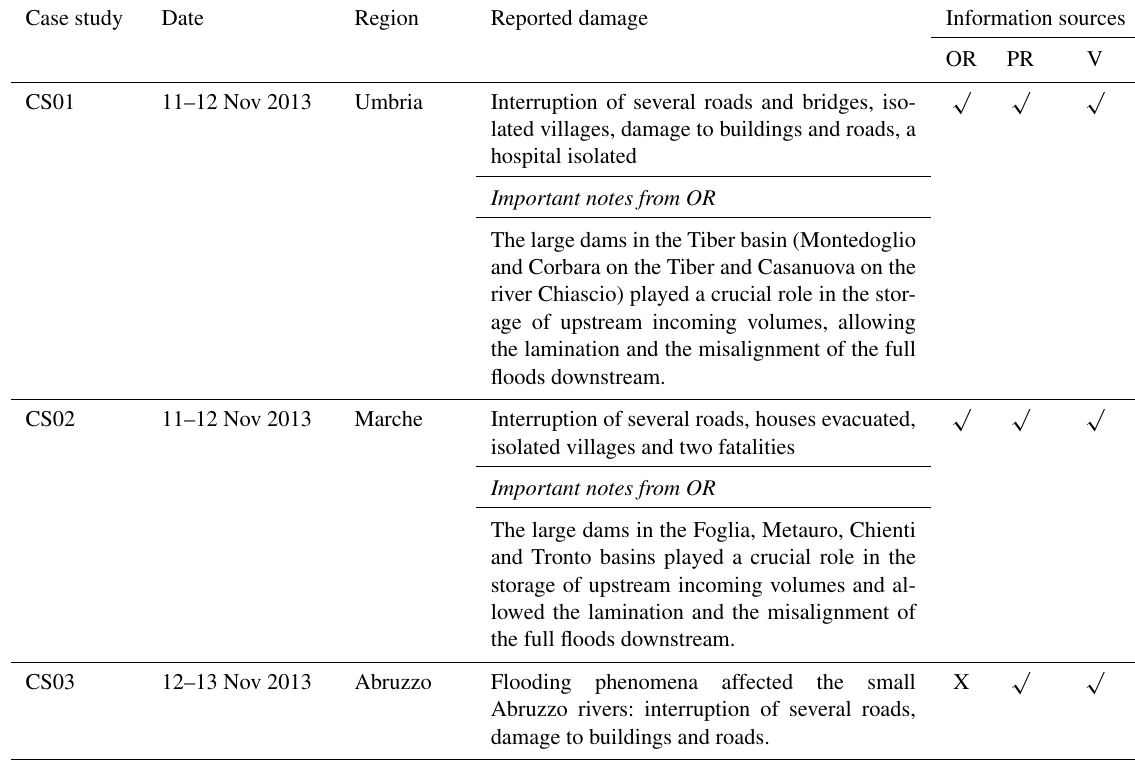
Table 2. Summary of relevant damage reported for each case study and information sources used. Case study